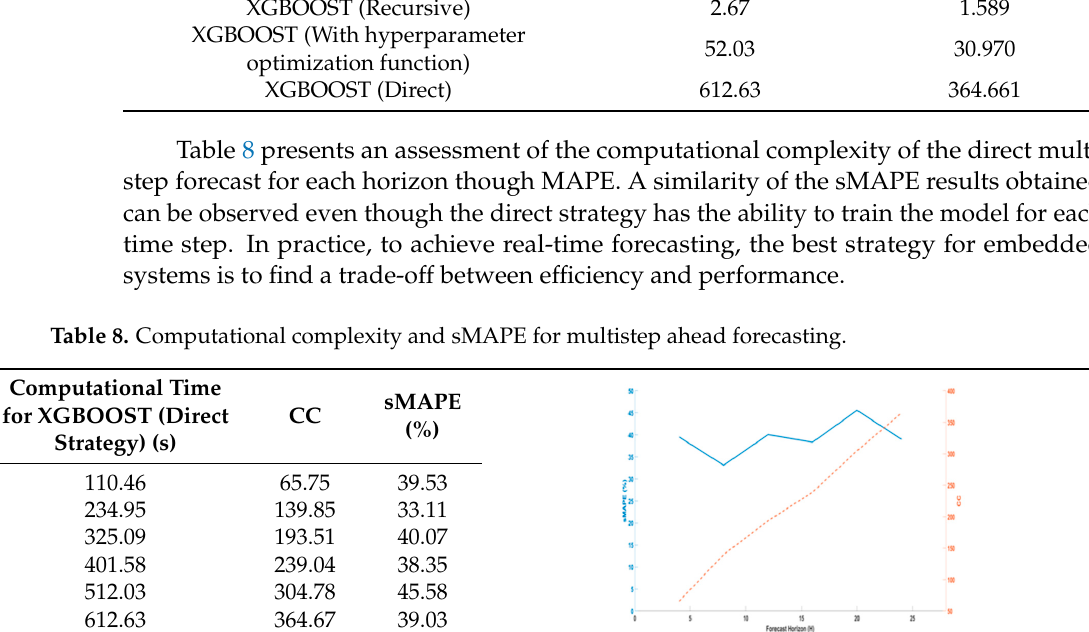
Table 7. Results Computational complexity for multistep ahead forecasting.